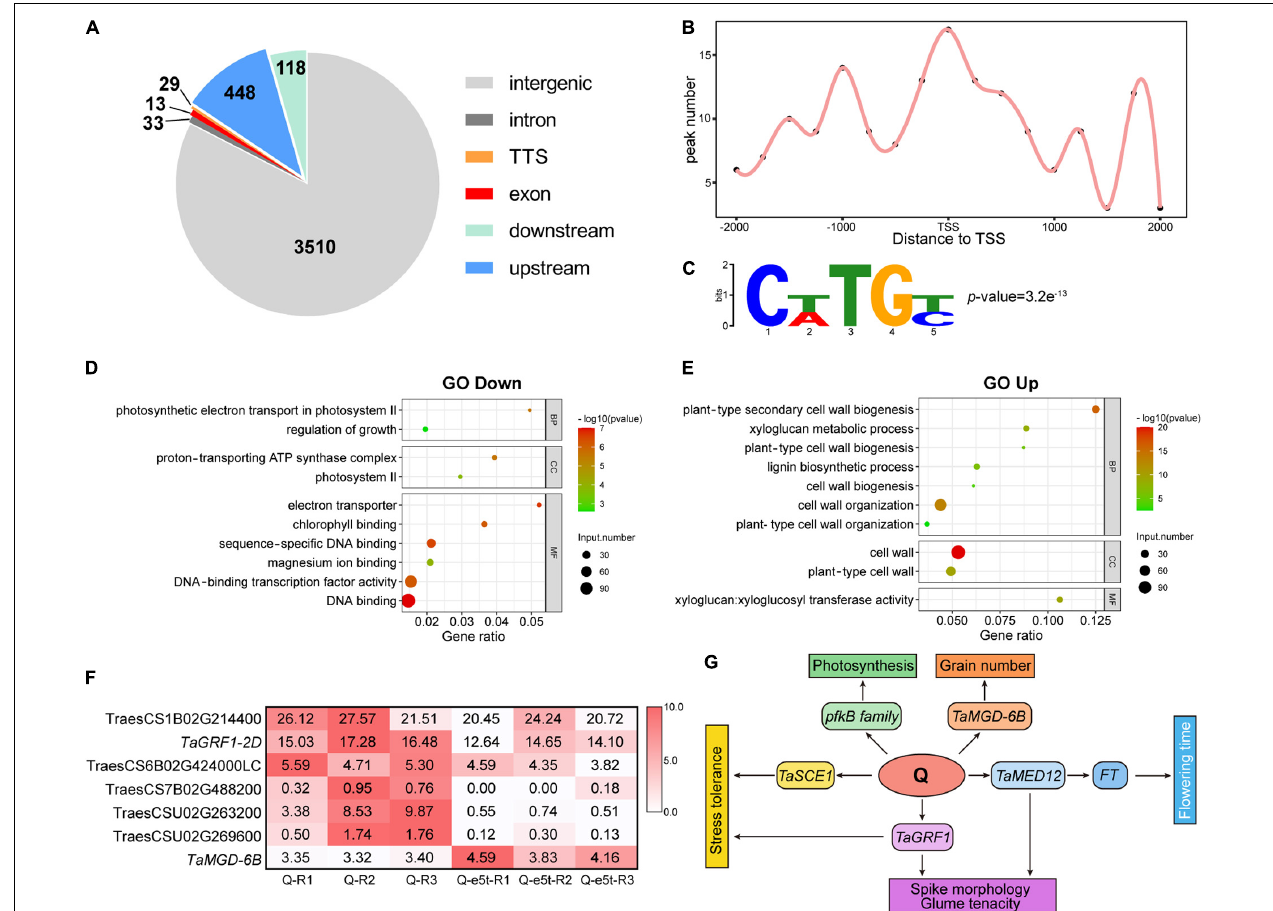
FIGURE 8 | Identification of genome-wide downstream targets of Q. (A) Genome-wide distribution of Q binding peaks. (B) The binding performance of Q in gene models. The x -axis indicates the distance to the TSS, and the y -axis indicates the number of peaks. (C) Q binding to the CTTGC core motif. The p -value was calculated by MEME. (D,E) GO enrichment analyses of down- and upregulated genes. The bubble size indicates the number of differentially expressed genes. The gene ratio is shown on the x -axis, and BP, CC, and MF on the y -axis indicate the biological process, cellular component and molecular function categories, respectively. (F) Heatmap showing the expression of 7 target genes bound by Q. The colors in the heatmap indicate the FPKM value. (G) Possible regulatory network of the Q